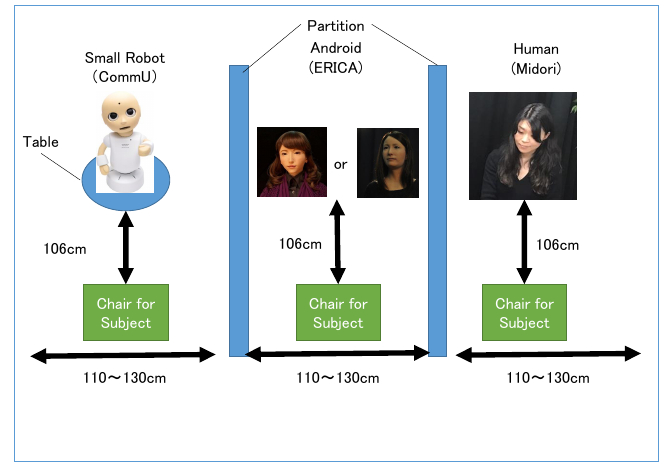
Figure 2. Experimental Settings.